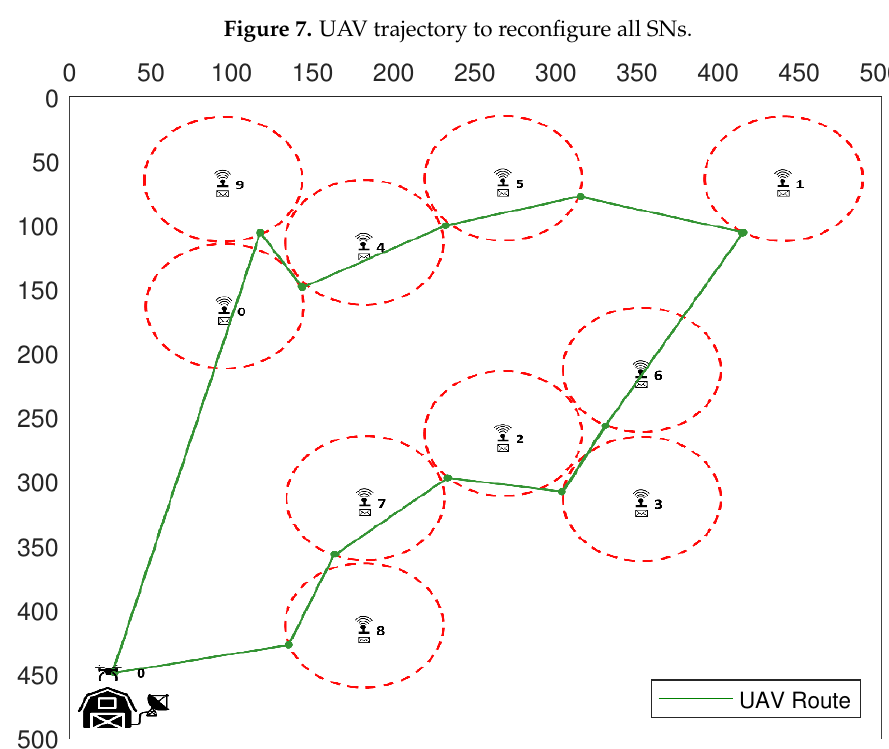
Figure 7. UAV trajectory to reconfigure all SNs.